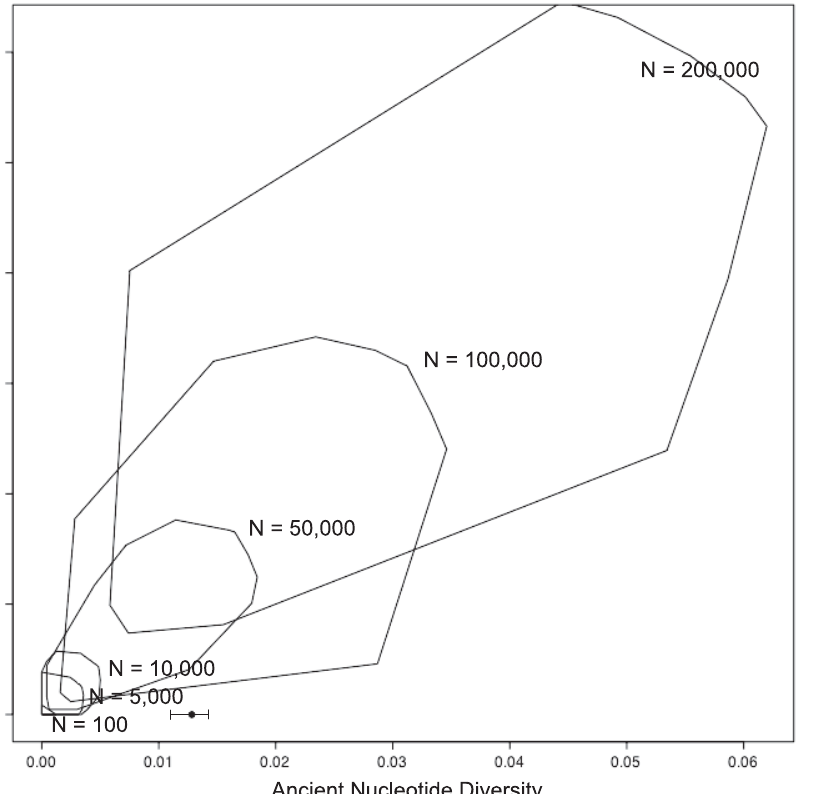
Figure 2. The Observed Ancient and Modern Diversity Plotted below ( (cid:2) ) with Standard Error Bars Shows the Rejection of the Null Model of a Constant Population with Sizes Ranging from 100 to 200,000 for the Modern and Ancient Nucleotide Diversity in C. sociabilis Found in Cueva Traful The 95% confidence hulls at each population size assume a single panmictic population based on 1,000 iterations of Serial Simcoal [4] for modern and ancient nucleotide diversity. DOI: 10.1371/journal.pgen.0020059.g002